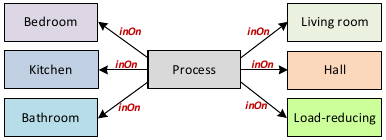
Figure 14. SHS—( a ) the “Bedroom” and ( b ) “Load-reducing” slave FSMs.